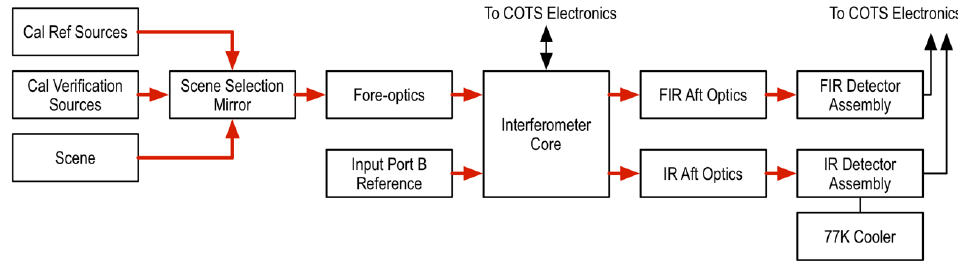
Figure 2. A notional illustration indicating the primary Absolute Radiance Interferometer subsystems and optical path.